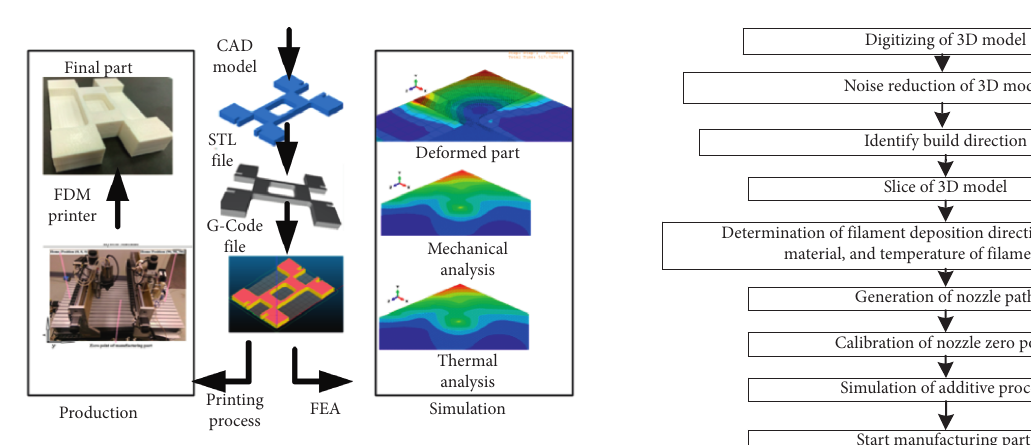
Figure 5: Schematic diagram of FEA.